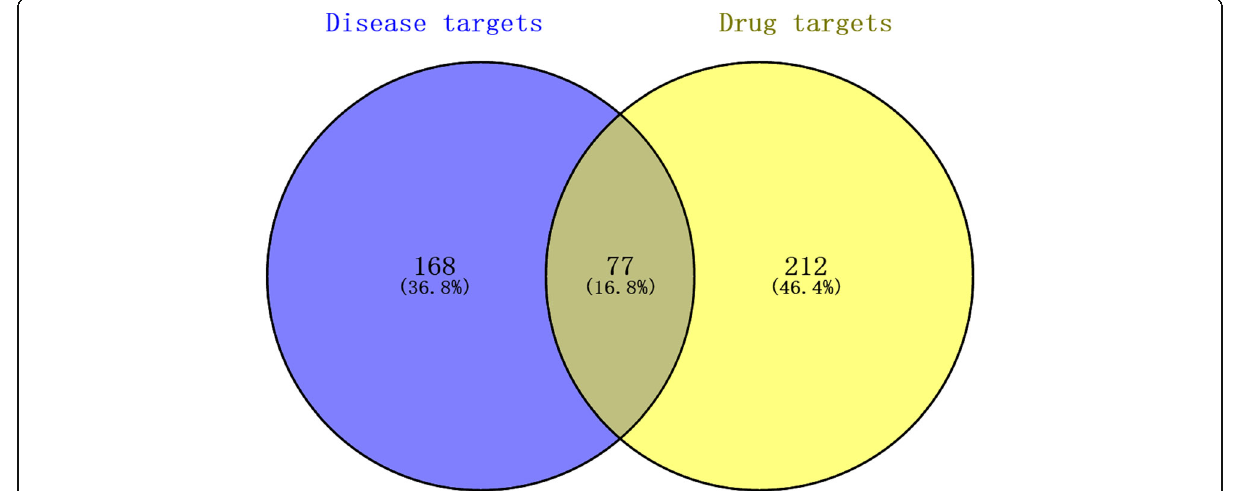
Fig. 3 The venn diagram of the targets both in pancreatic cancer targets and Wumei pill